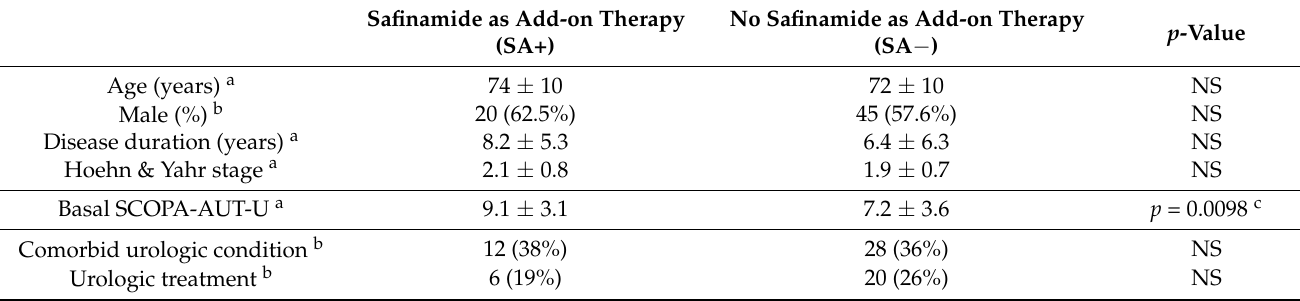
Table 1. Clinical and demographic variables comparison between safinamide group and no safinamide group. Safinamide as Add-on Therapy No Safinamide as Add-on Therapy (SA+) (SA −